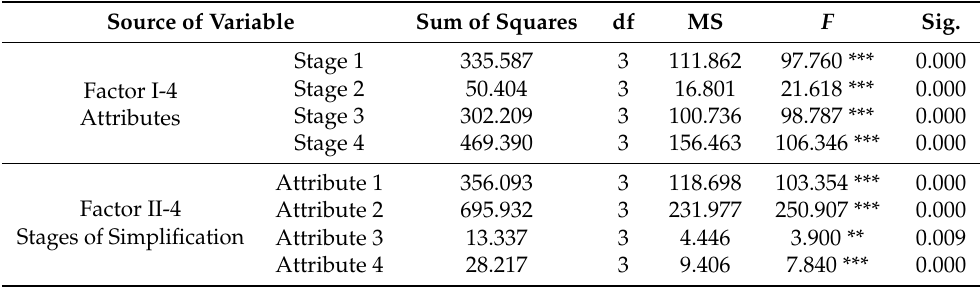
Table 7. Summary of simple main